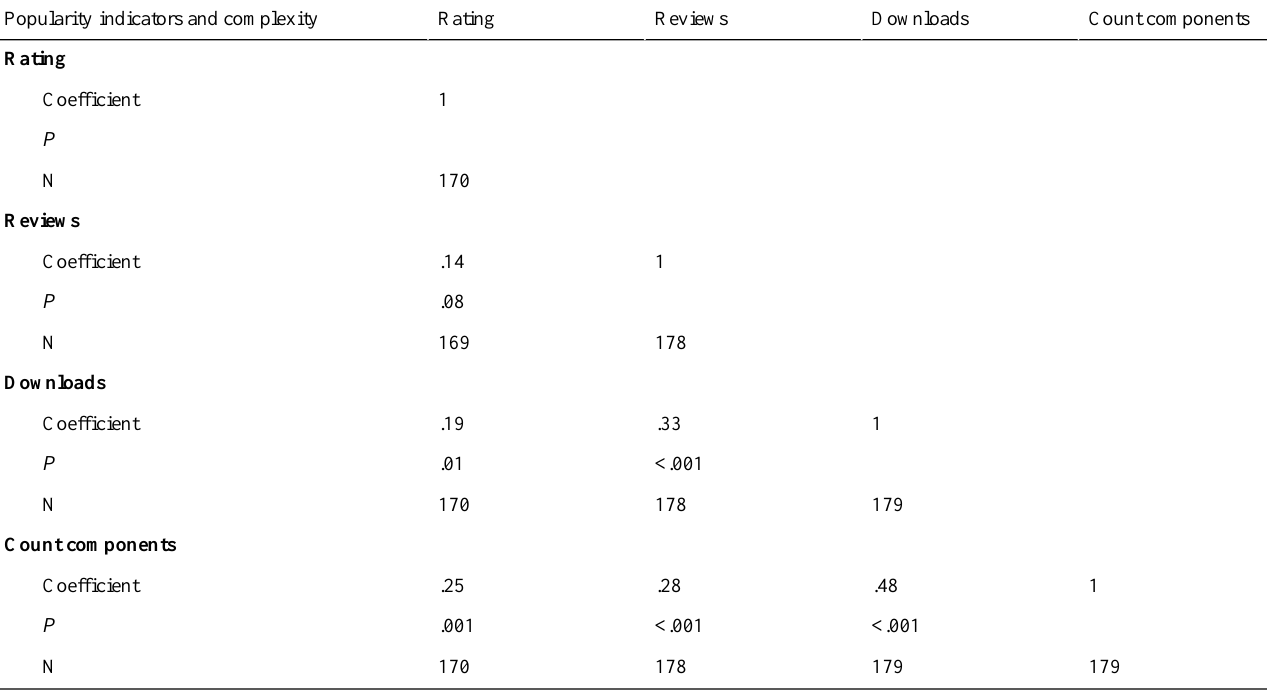
Table 3. Pearson correlations assessing the association of the complexity of weight loss apps with the three popularity indicators: rating, number of reviews, and number of